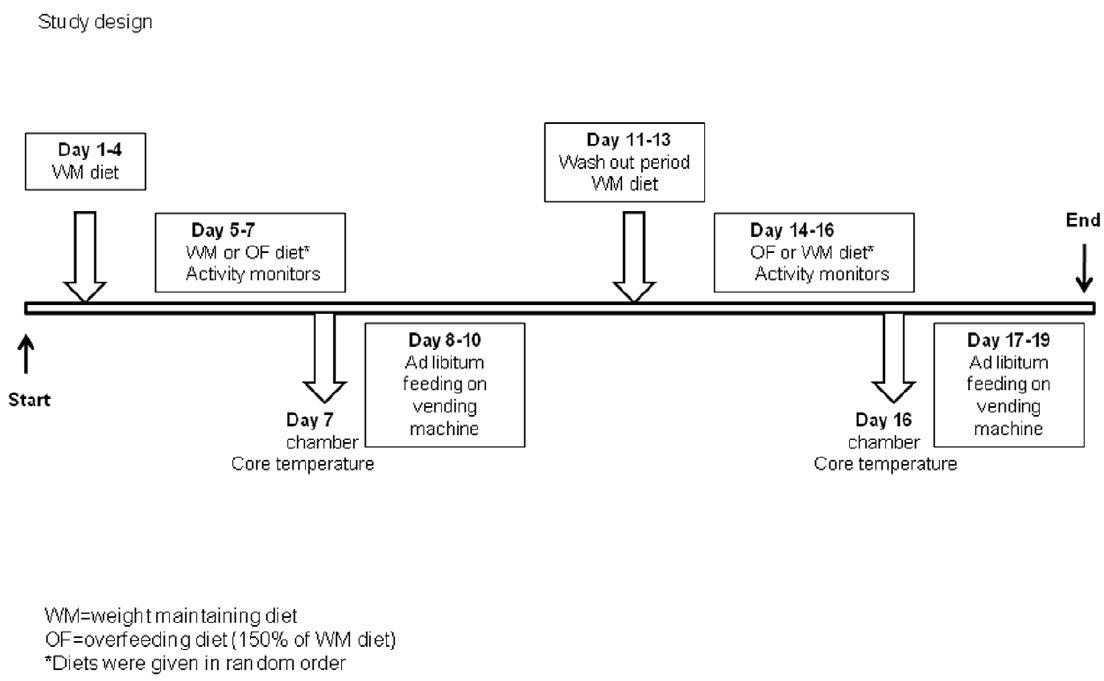
Figure 1. On admission volunteers were started on a standard weight maintaining diet for 4 days. On days 5–7 volunteers were randomized to continue on their weight maintaining diet (WM) for an additional 3 days or start 3 days of an overfeeding diet (OF) equal to 150% of their weight maintenance diet in calories. During each 3 day diet period volunteers also wore accelerometers. On the final day of the WM or OF periods, volunteers were placed in the respiratory chamber for 24 hours for measurement of energy expenditure and they received the core temperature capsule. On days 8–10, ad libitum food was assessed using the automated vending machine. Following the 3 days of ad libitum food intake, volunteers resumed their weight maintaining diet for 3 days (as a wash out period) followed by another 3 days of either the WM or OF